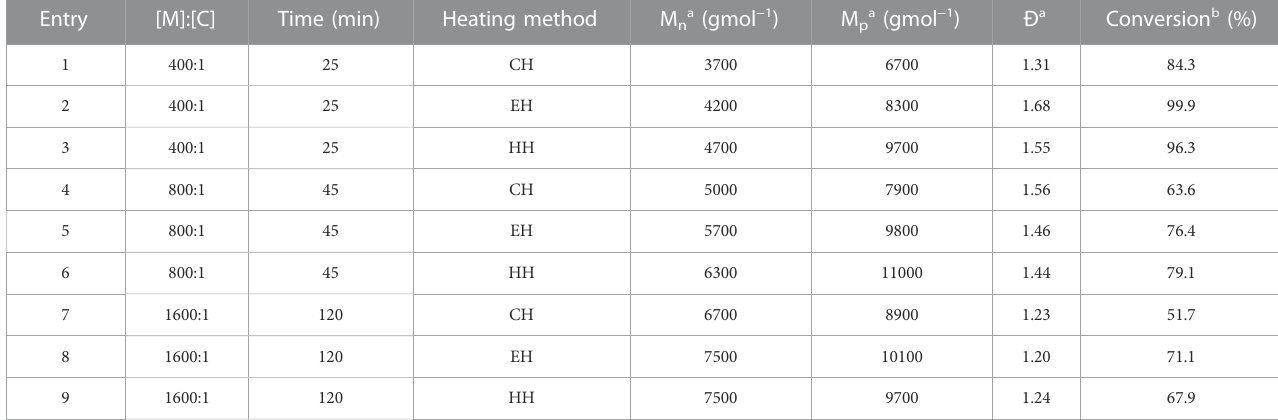
TABLE 5 Average results of ROP of CL with FeCl 3 and BzOH at various [M]:[C] ratios at 100 ° C.